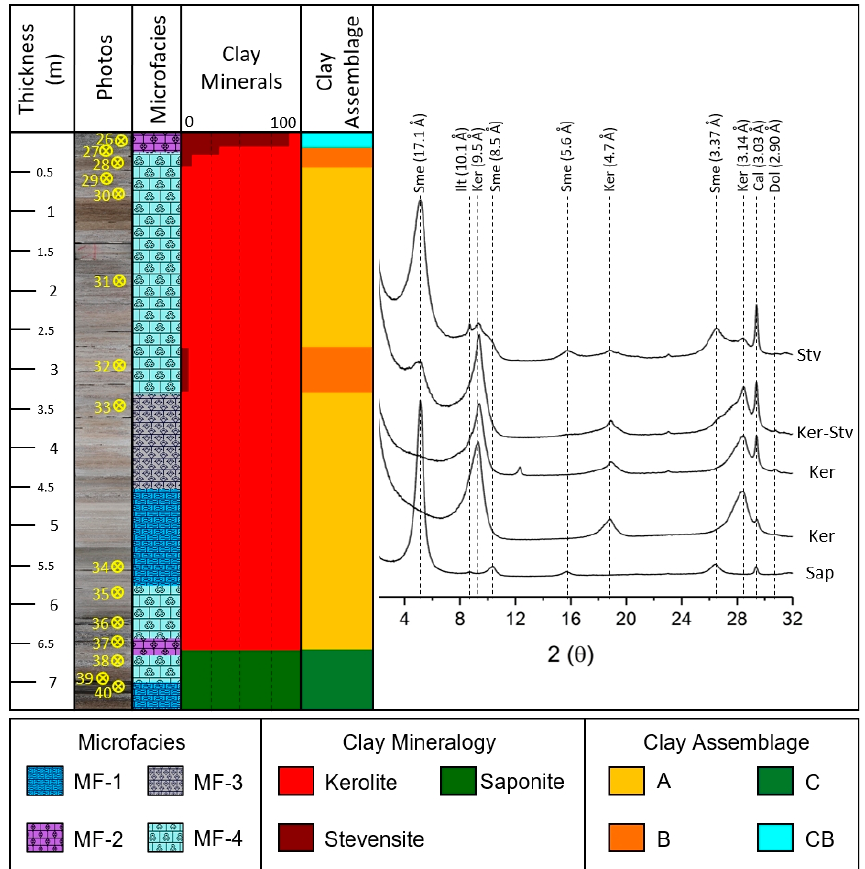
Figure 6. Mineralogical sequence 2. The rocks, clay minerals, assemblages and representative XRD patterns are shown. Ker. Kerolite. Sme (smectite), Ilt (illite), Cal (calcite) and Dol (dolomite).